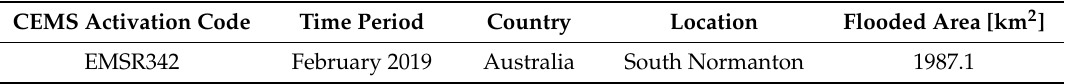
Table 1. Test case considered in this study for flood